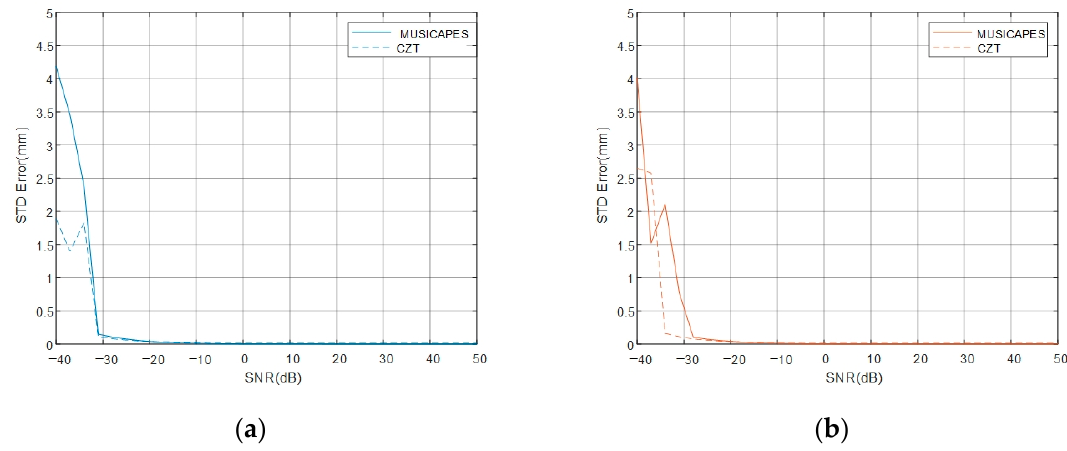
Figure 12. STD of displacement difference vs. SNR. ( a ) STD of ‘Target1’; ( b ) STD of ‘Target2’.